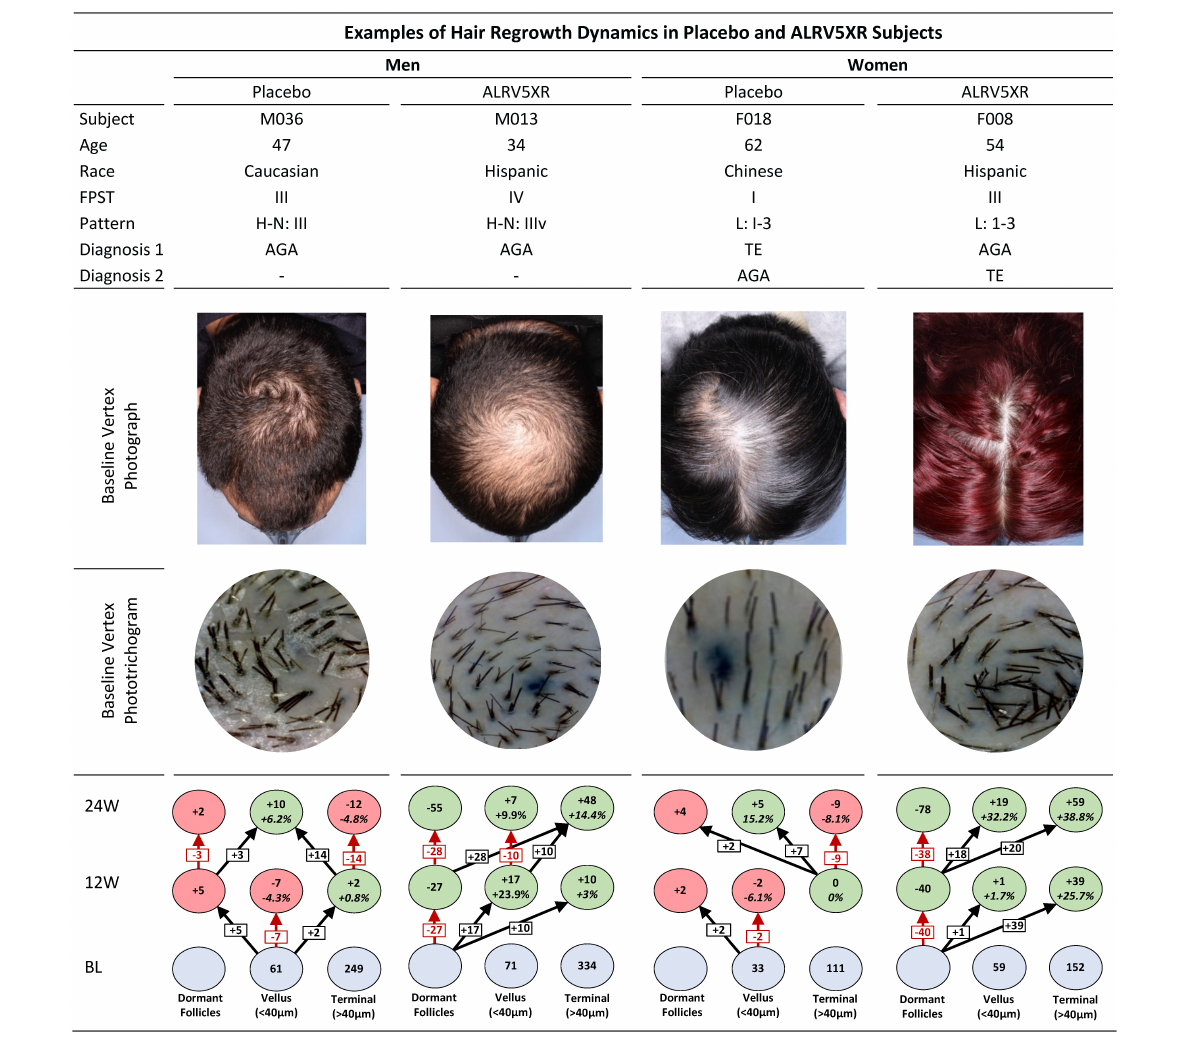
FIGURE3 Examples of hair regrowth dynamics of ALRV5XR vs. Placebo in subjects over 24 weeks. This figure shows the individual hair regrowth dynamics of four subjects, one male and one female in placebo and ALRV5XR treatment arms. The clinical context of each subject is presented with baseline global vertex photographs and phototrichogram images. The corresponding hair regrowth dynamics chart after 12 and 24 weeks shows the placebo subjects with a progressive reduction in terminal hair density, miniaturizing of terminal hair to vellus hair, and the increasing of empty hair follicles. The ALRV5XR subjects show a completely opposite dynamic of progressive terminal hair regrowth, miniaturization reversal, and decreasing empty follicles. FPST, fitzpatrick skin type; Pattern, H-N: Hamilton Norwood; L, Ludwig; Diagnosis 1 and 2, primary and secondary diagnosis; BL, baseline, 12W and 24 are 12 and 24 weeks, respectively. Blue ovals are absolute terminal or vellus hair counts at BL. Dormant follicle counts at baseline are not known. Values at 12 and 24 weeks are absolute and relative changes in hair counts from baseline. For vellus and terminal hairs, green ovals represent increases in hair, and red ovals represent decreases. Decreases in dormant follicles are colored green. Changes in dormant follicles account for less empty follicles due to new hair regrowth. Vellus hairs include true vellus, vellus-like, and new hairs. Arrows in black show new hairs from dormant follicles regrowing into vellus or terminal hairs, vellus hairs thickening into terminal hairs, terminal hair miniaturizing into vellus. Arrows in red are reductions in vellus hairs, terminal hairs, or increases in dormant follicles.